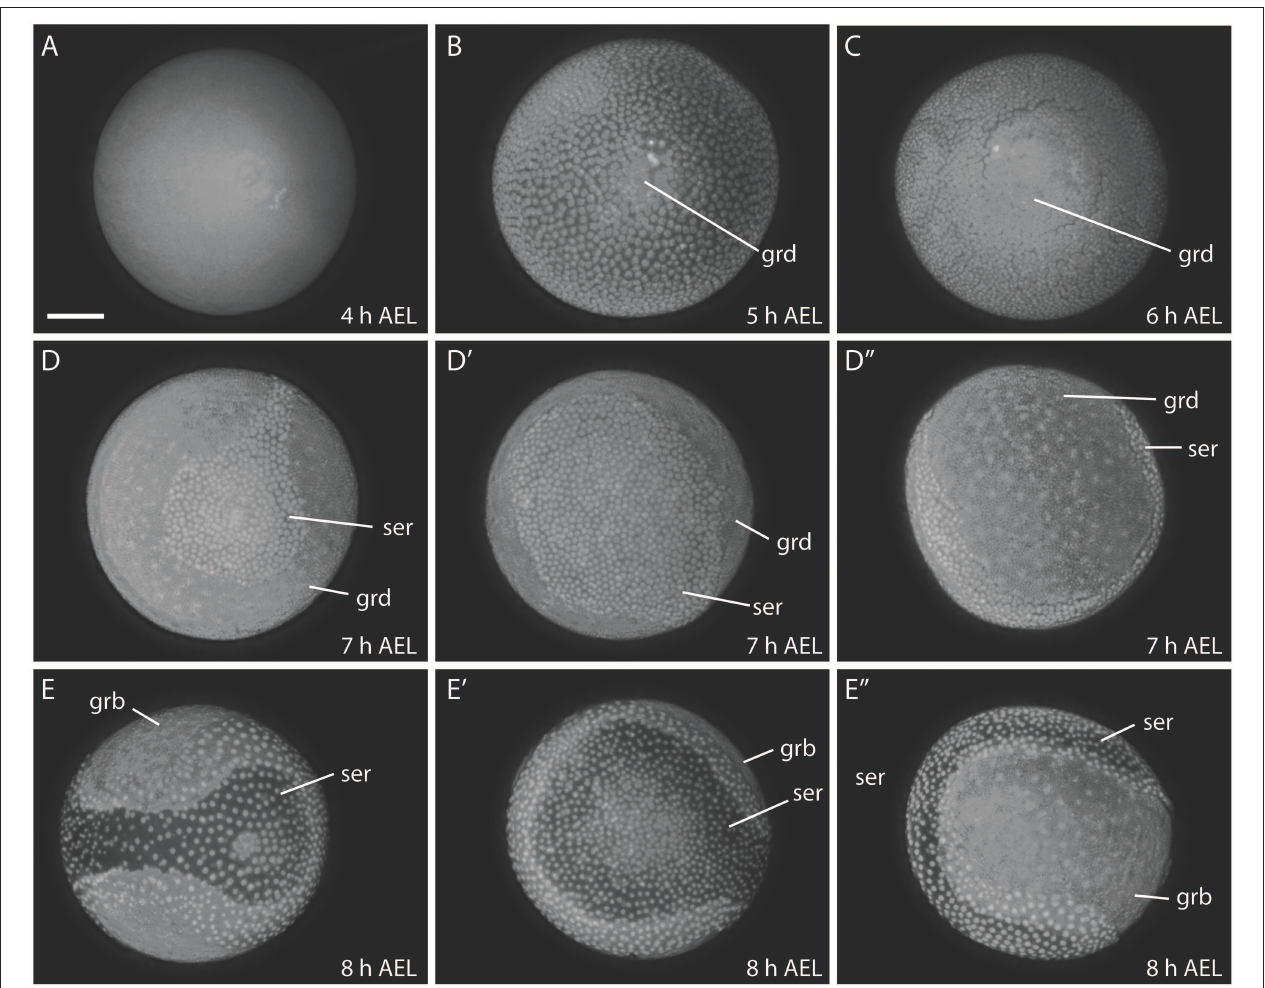
FIGURE 4 | Early developmental stages of B. anynana from 4 to 8h. The germ disc starts to form around 5h AEL (A,B) , expands at 6h AEL (C) and forms the germband at around 8h AEL (D–E ′′ ) . See detailed descriptions in the main text. All embryos are stained with DAPI. AEL, after egg laying; grd, germ disc; grb, germ band; ser, serosa. Scale bar: 400 µ m; all panels are at the same